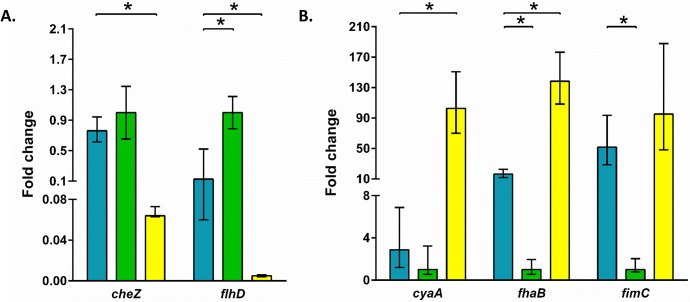
Gene expression of B. bronchiseptica in sori.Genes associated with Bvg- (A) and Bvg+ (B) were selected, and the expression of those gene transcripts was compared with B. bronchiseptica isolated from sori (blue) against Bvg- (green) and Bvg+ (yellow) phase-locked mutants grown in liquid culture. Data represent the mean fold change in gene expression levels (with standard deviations) relative to the Bvg- phase-locked mutant RB54 from three independent experiments. An asterisk (*) indicates significantly different expression levels (p-value ≤ 0.05) in pair-wise comparisons. For further details, please see S2 Data.